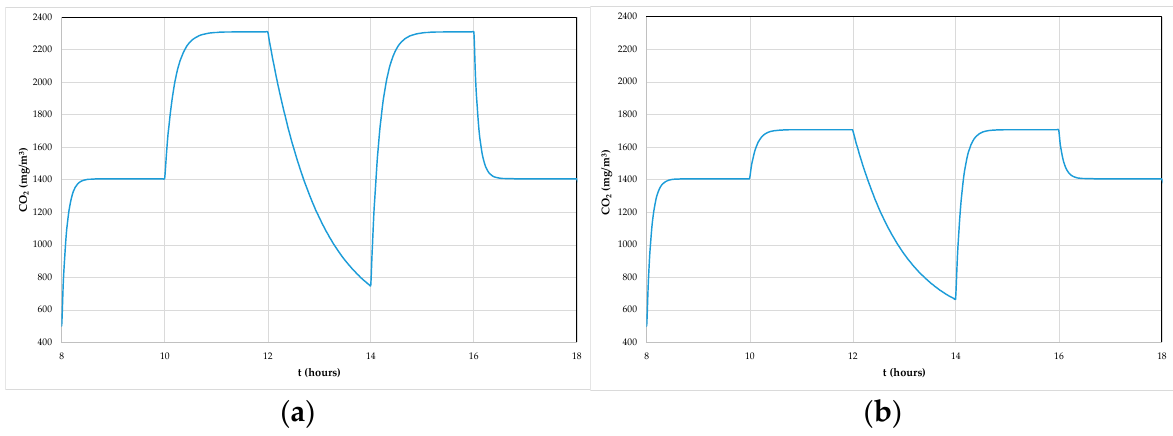
Figure 9. Evaluation of carbon dioxide (CO 2 ) concentration for Case E ( a ) and Case F ( b ).